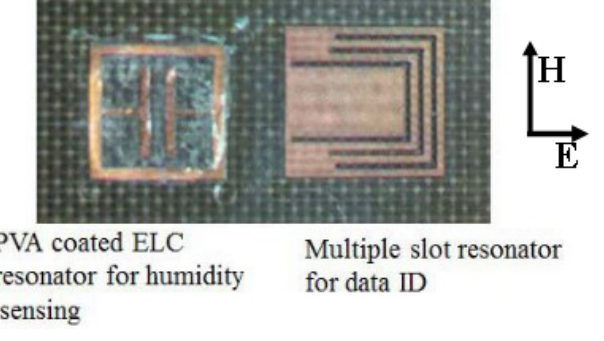
Figure 16. Fabricated circuit of the chip-less RFID tag humidity sensor